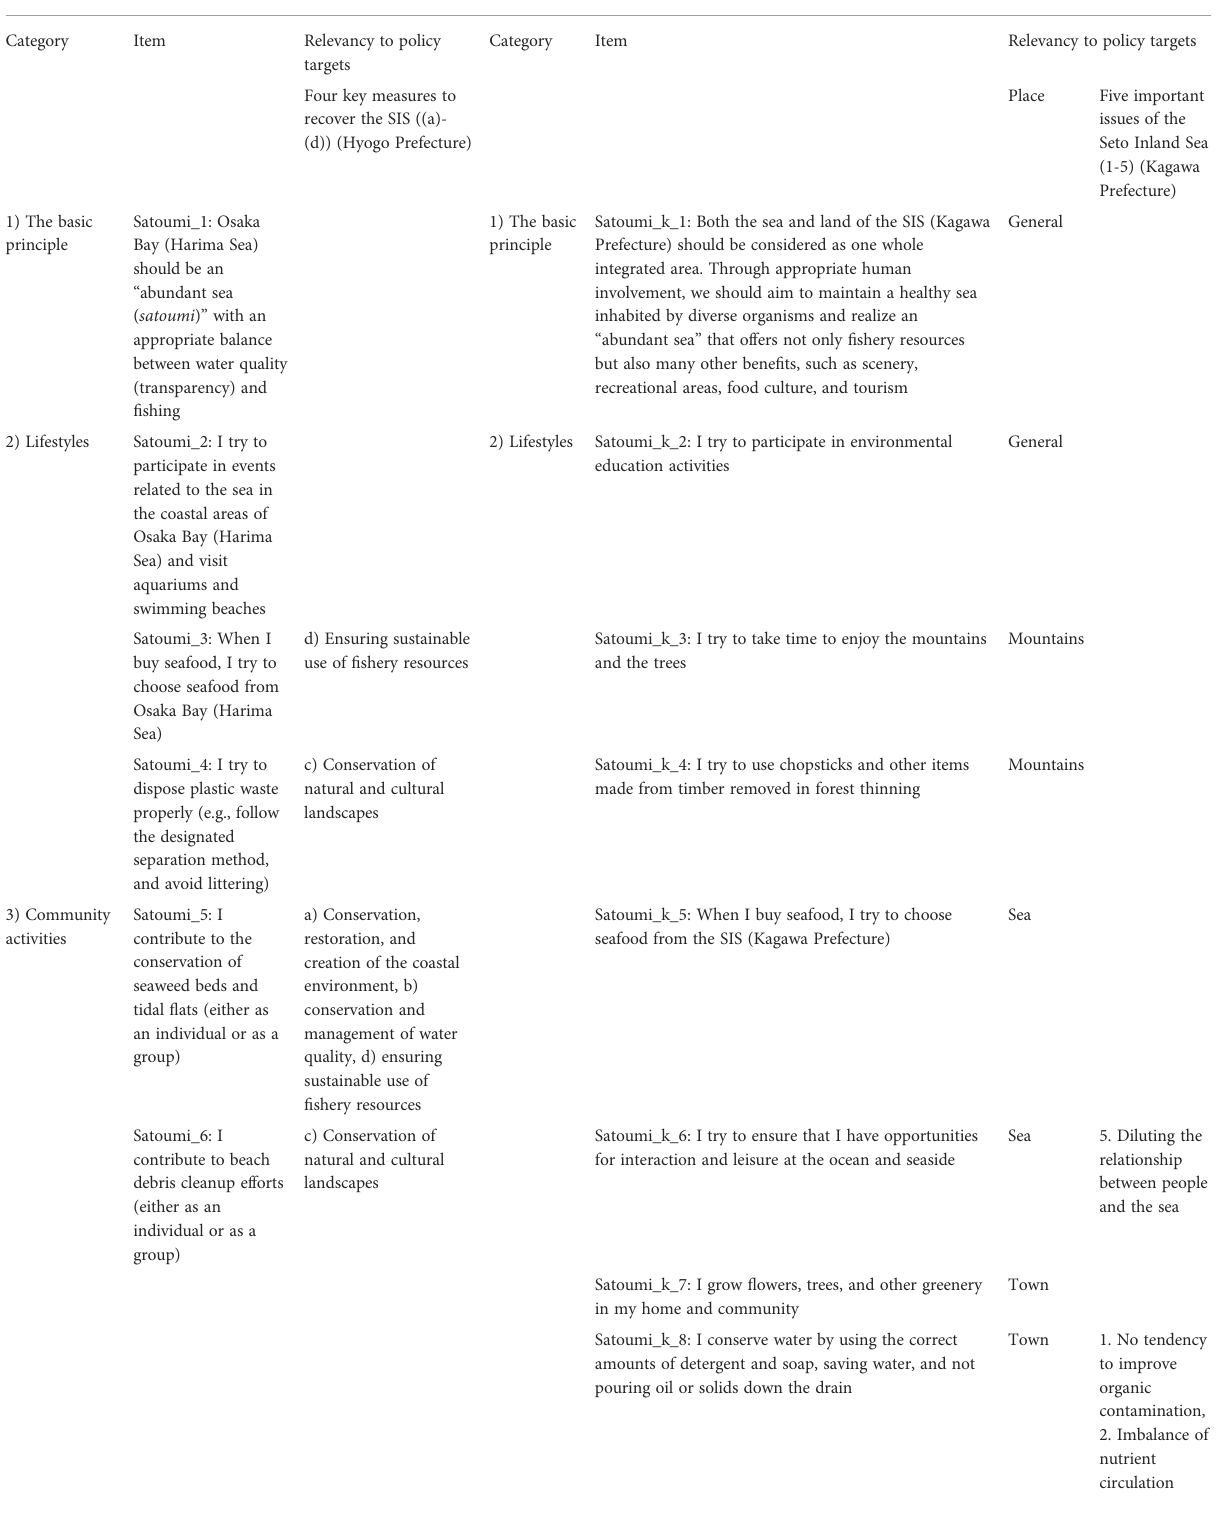
TABLE 3 Pro-SES behavior scales for the three